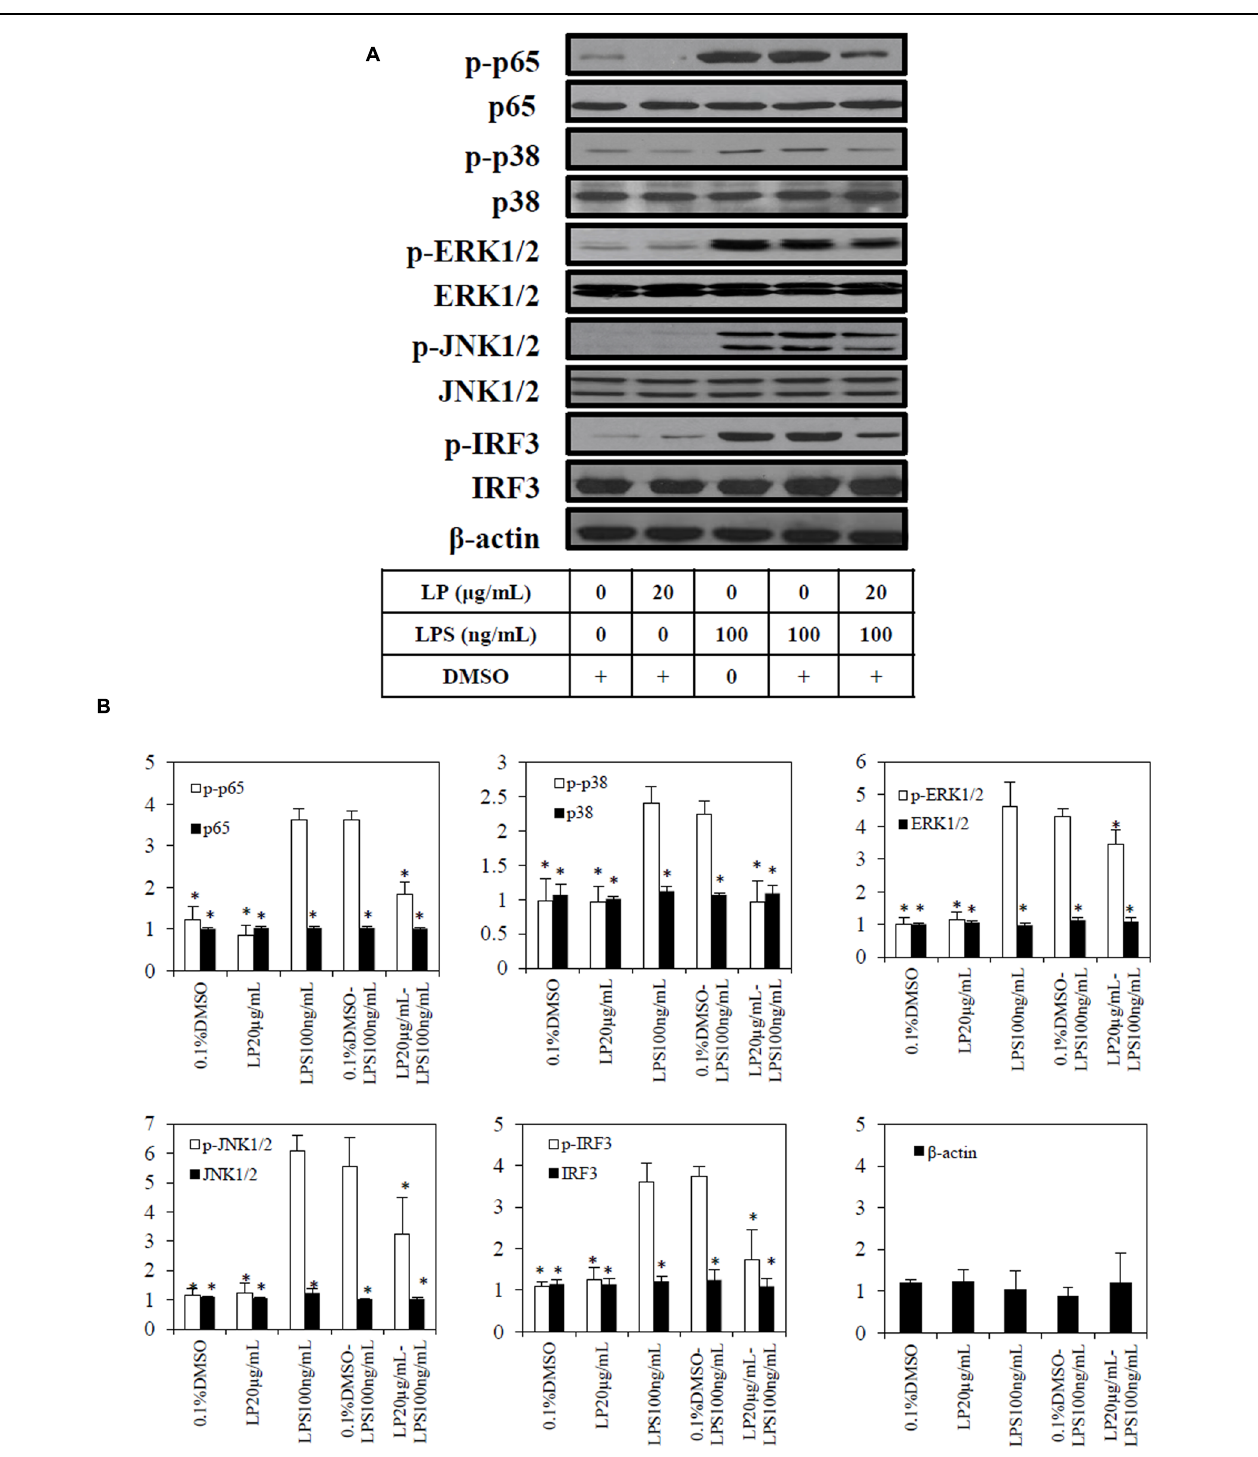
FIGURE 5 | Effect of extract (LP) on LPS-induced p65, p38, pERK1/2, pJNK 1/2, pIRF3, and β -actin in RAW264.7 macrophages. RAW264.7 macrophages were pre-treated with vehicle (0.1%DMSO) or the most potent extract (20 μ g/mL) of LP for 1 h before stimulation with LPS (100ng/mL) for 18 h. (A) Whole-cell extracts were assayed for its phosphorylated and non-phosphorylated p65, p38, pERK1/2, pJNK 1/2, pIRF3, and β -actin as described in Materials and methods. (B) Quantification of each blot was performed by scanning densitometry. Each blot is representative of three others. Each value is the mean ± SD of three independent immunoblotting experiments, with ∗ p < 0.05 from macrophages treated with LPS alone.